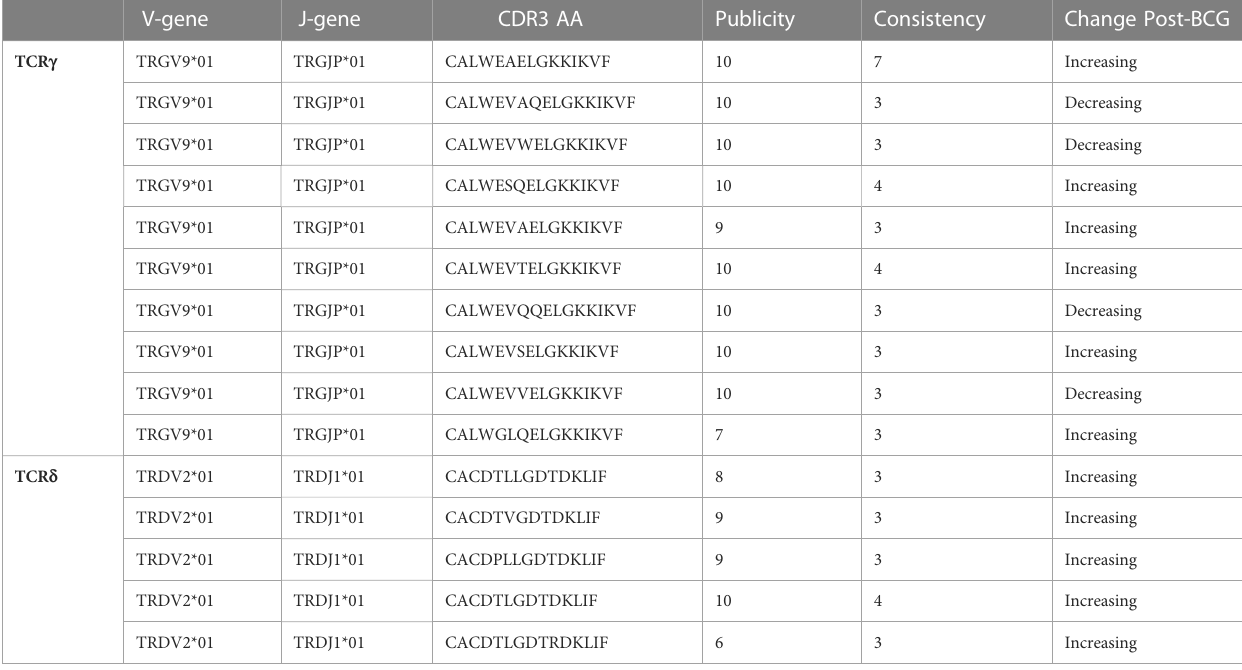
TABLE 1 TCR g and TCR d clonotypes with signi fi cant (FDR-q < 0.05) and consistent ( ≥ 3 individuals) changes after BCG vaccination.